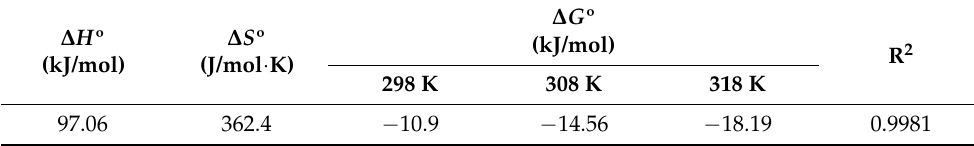
Table 3. Thermodynamic parameters for adsorption of Ru(III) onto